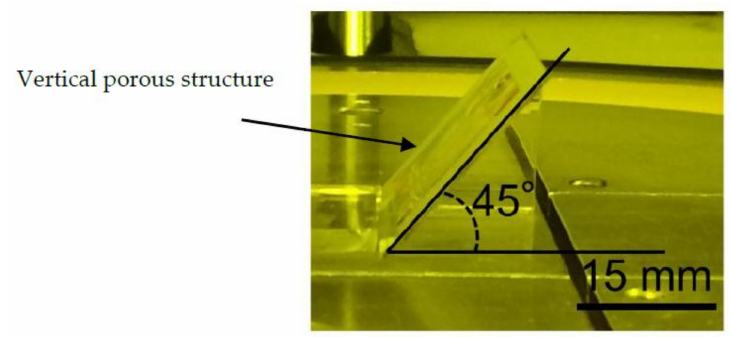
Figure 3. Inclined oxygen ashing method. Oxygen plasma irradiates the vertical porous membrane, inclined at 45 ◦ on an ashing stage. Ashing was performed twice from both sides of the vertical porous